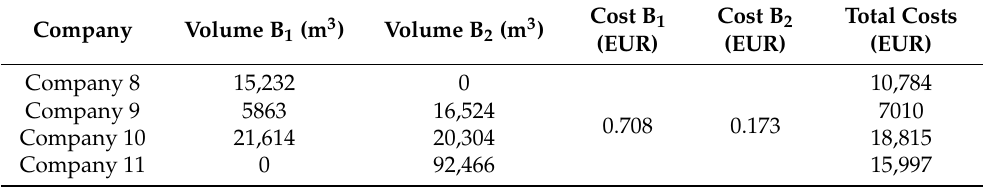
Table 14. B 1 and B 2 quality production costs for quarterly consumption for Sector